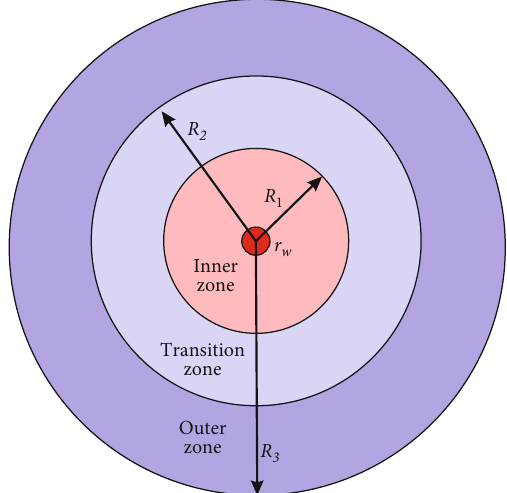
Figure 5: Physical model of three-zone radial composite